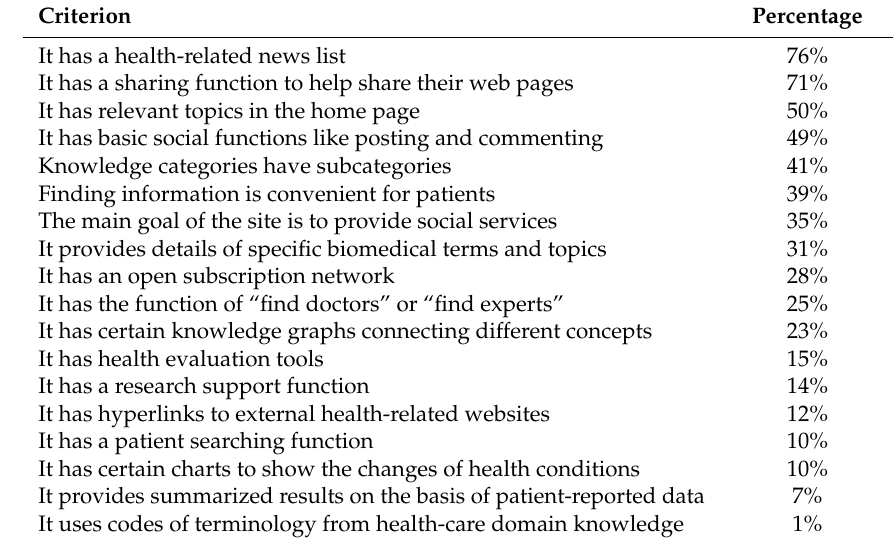
Table 7. Evaluation results of 100 health-related websites by investigating how domain knowledge affects